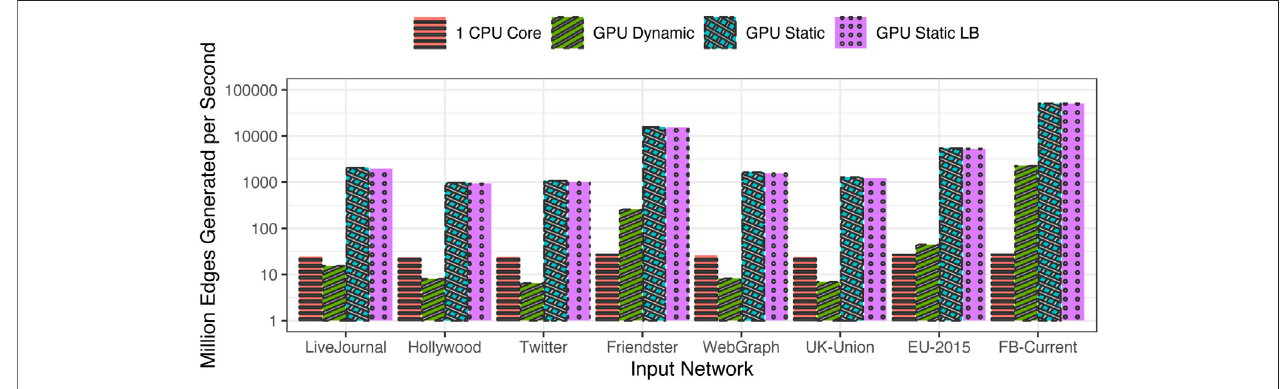
FIGURE 7 | Million edges generated per second for the coarsened distribution.